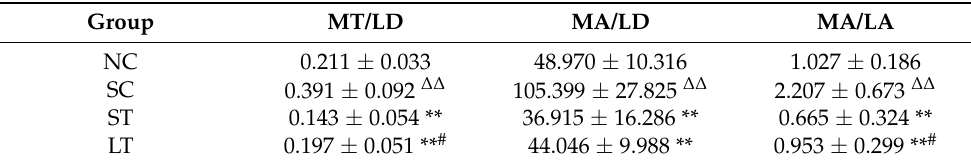
Figure 4. The kidney. NC group ( A ), SC group ( B ), ST group ( C ), and LT group ( D ). Table 3. Morphological parameters of intrarenal arterioles after training.